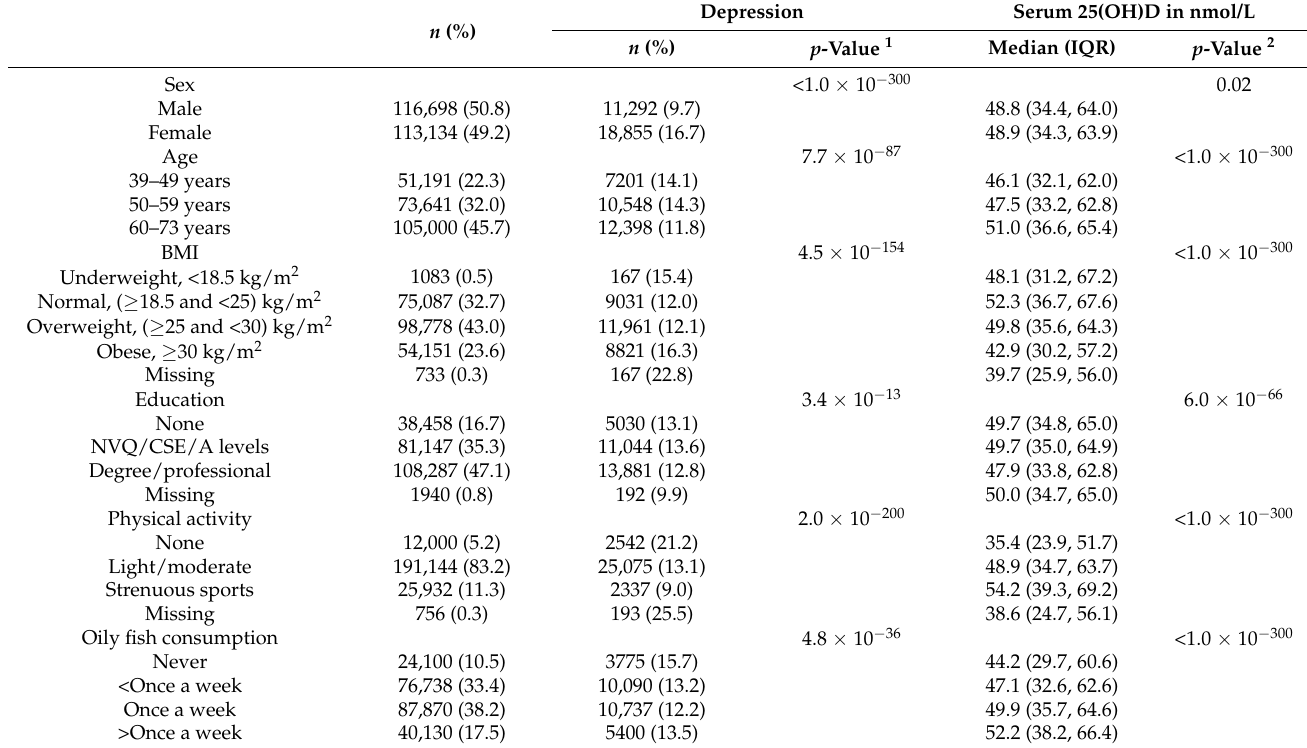
Table 1. Prevalence of depression and summary of serum 25(OH)D (in nanomoles per litre, nmol/L) across different